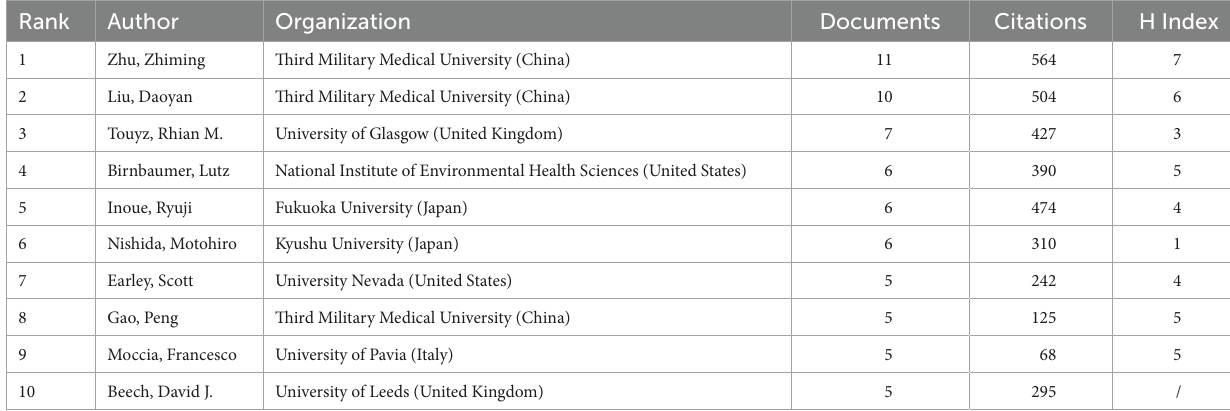
TABLE 3 Top 10 core authors with the most published